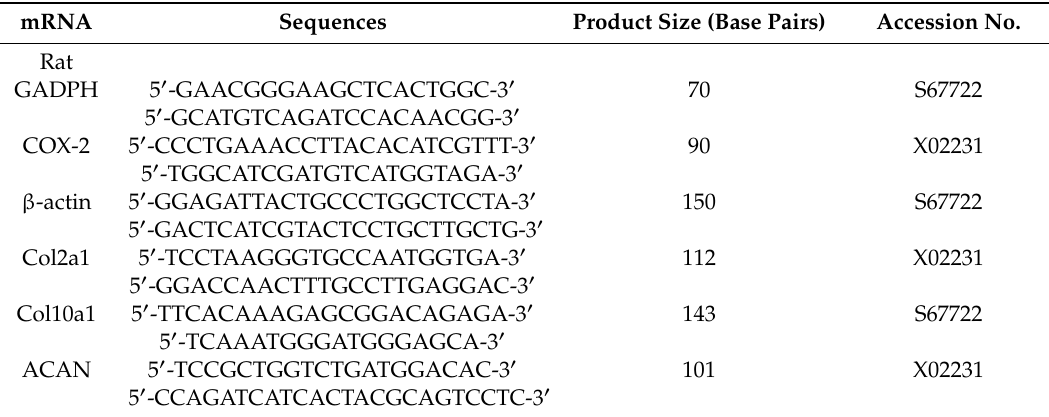
Table 1. Oligonucleotide primers for semiquantitative RT-PCR